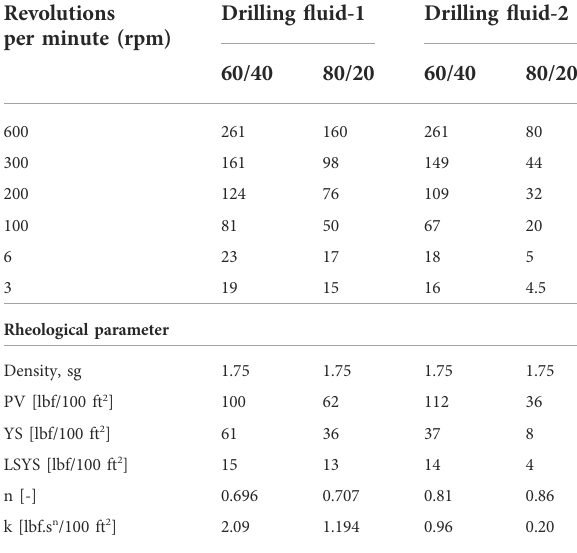
TABLE1Measuredviscometer,density,andthecalculatedrheological parameters of drilling fl uids. Revolutions per minute